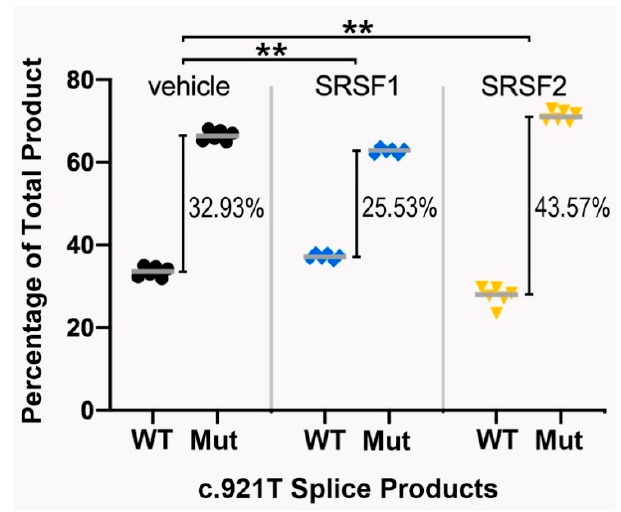
Figure 3. The splice regulatory factors impact the extent of abnormal splicing caused by the synonymous IRF6 c.921C>T variant. The total amount of PCR splice products (WT: band 1, Mut: bands 2–4, as per Figure 2B) were quantified and expressed as a percentage of the total. Six replicates were performed. Statistical analysis was carried out using two-tailed Student’s t -tests; ** p < 0.05. Actual p -values from the tests are presented within the main text.